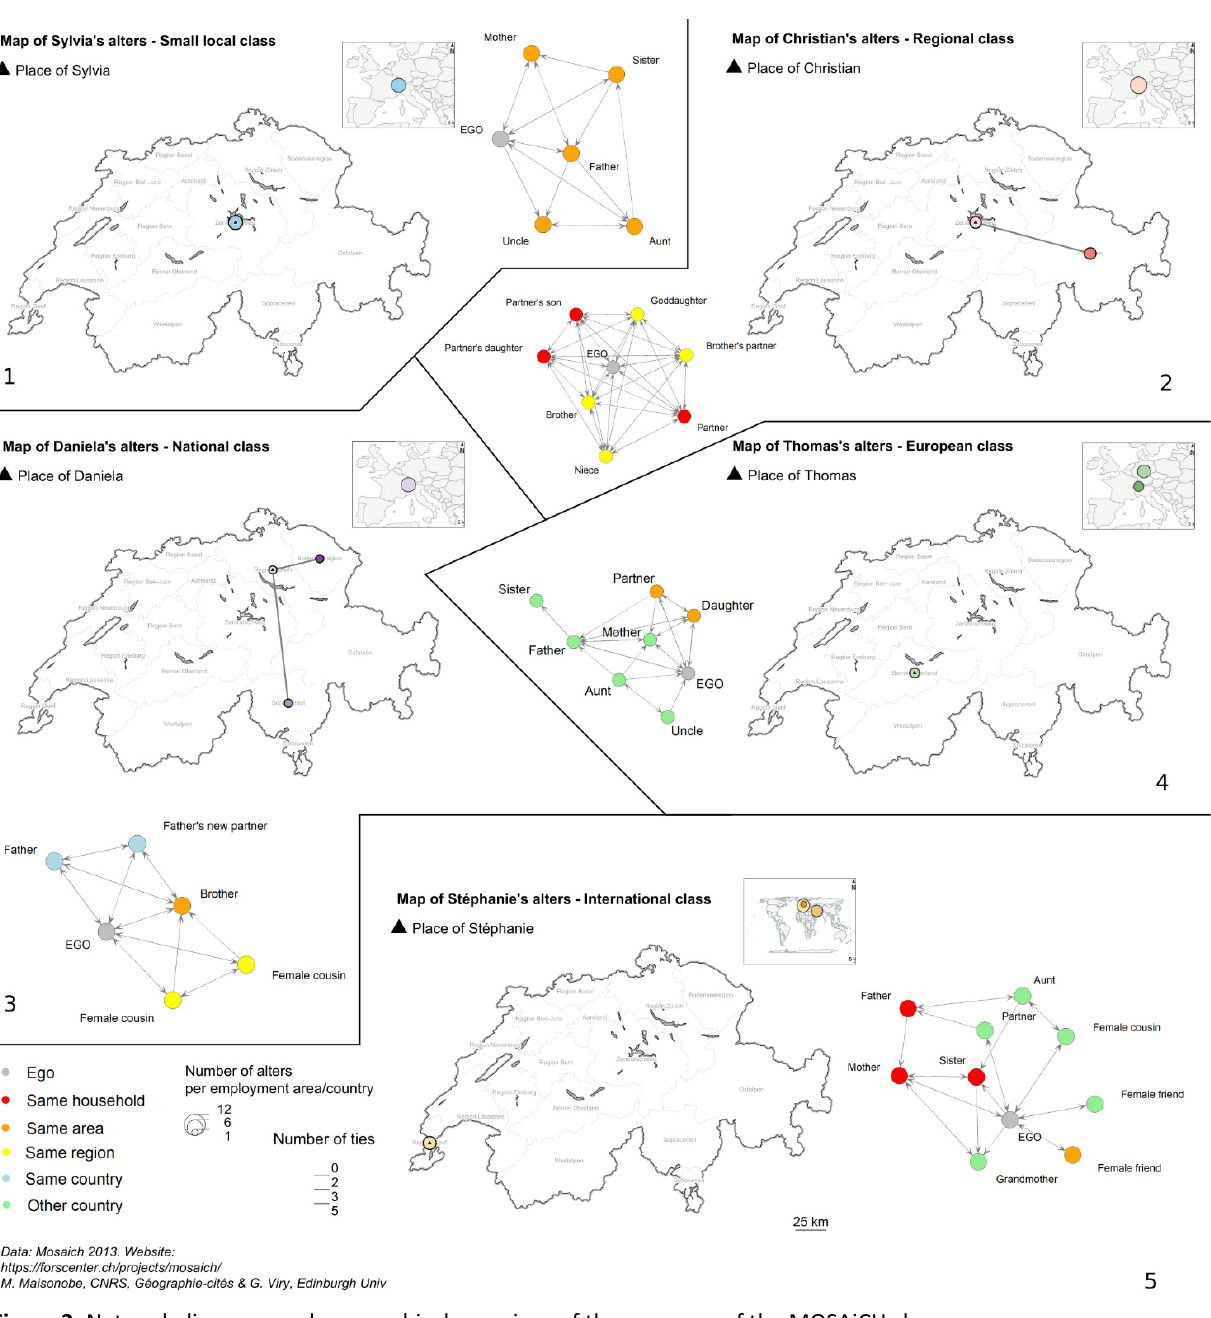
Figure 3. Network diagrams and geographical mappings of the paragons of the MOSAiCH